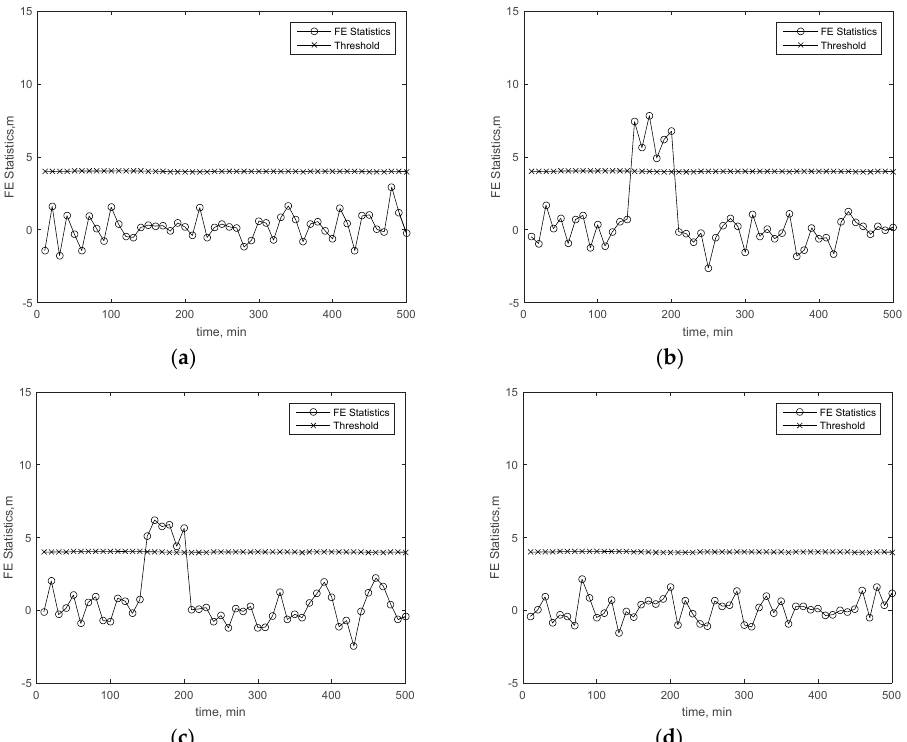
Figure 6. FE test results over all time in the second case. ( a ) FE test of the first satellite. ( b ) FE test of the third satellite (failing satellite). ( c ) FE test of the fifth satellite (failing satellite). ( d ) FE test of the sixth satellite.